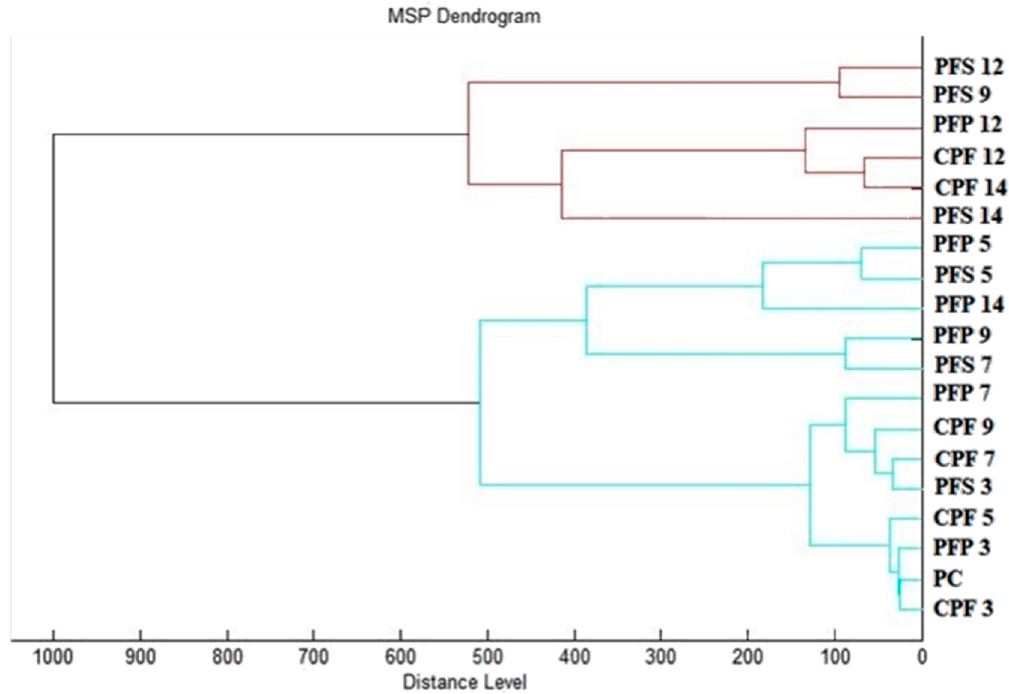
Figure 2. Dendrogram of P. fluorescens biofilm progress after SSEO exposition. PF— P. fluorescens ; C—control; S—stainless-steel; P—plastic; P—planktonic cells. Table 8. Insecticidal activity of